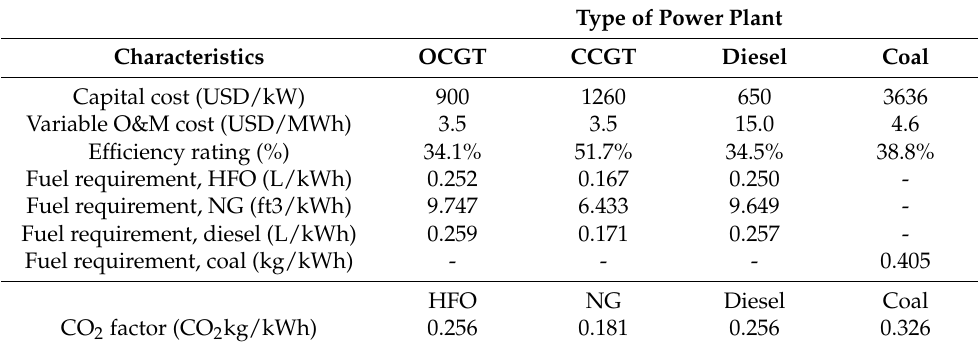
Table 3. Cost assumptions on alternative thermal